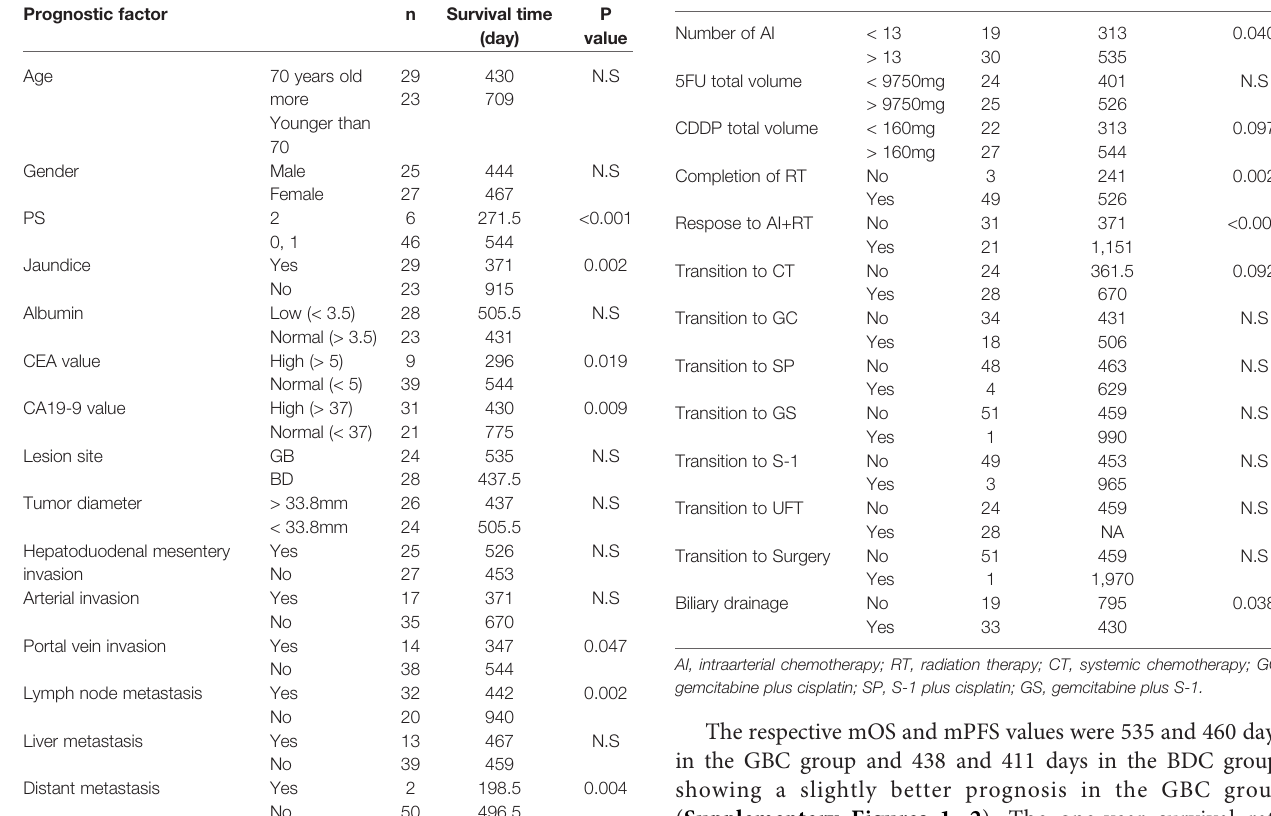
TABLE 3A | Prognostic factors in all biliary tract cancers (BTCs): univariate analysis (patient and tumor factors). Prognostic factor